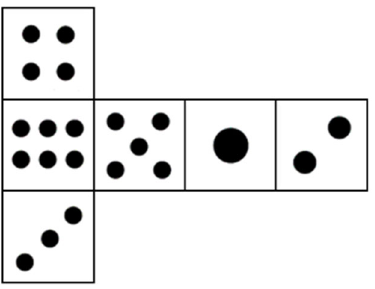
Figure 4. Chirality of the dice used for the proposed method.